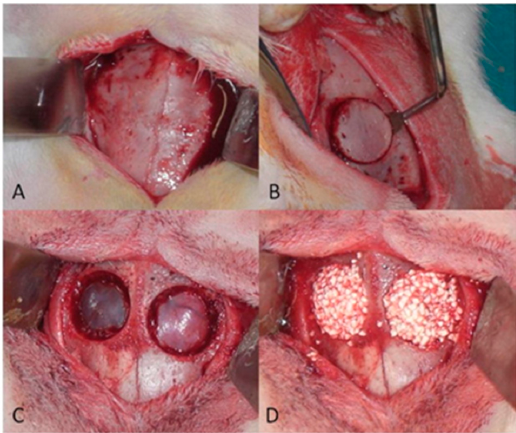
Figure 4. ( A ) Rabbit calvaria exposed; ( B ) removal of bone block; ( C ) bone defects exposed; ( D ) bone defects filled with bone substitute. Reprinted from [84] with permission from Elsevier.